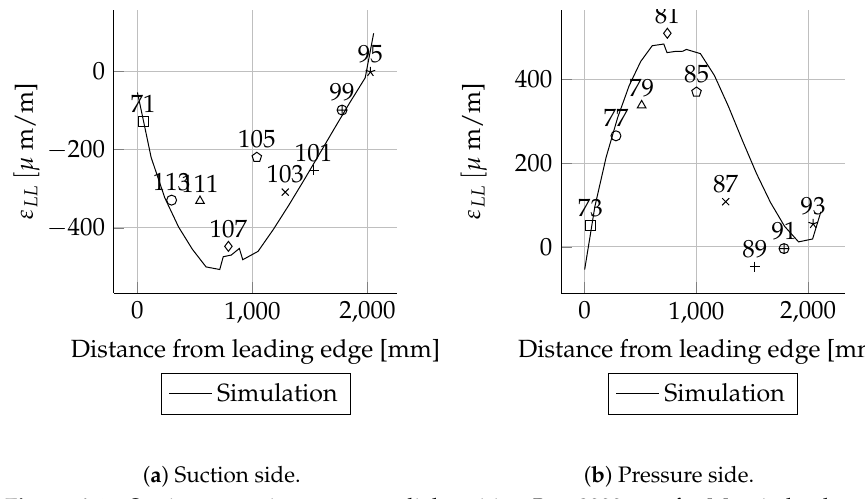
Figure A47. Strain comparison ε TT at radial position R = 8000 mm for Mymin load